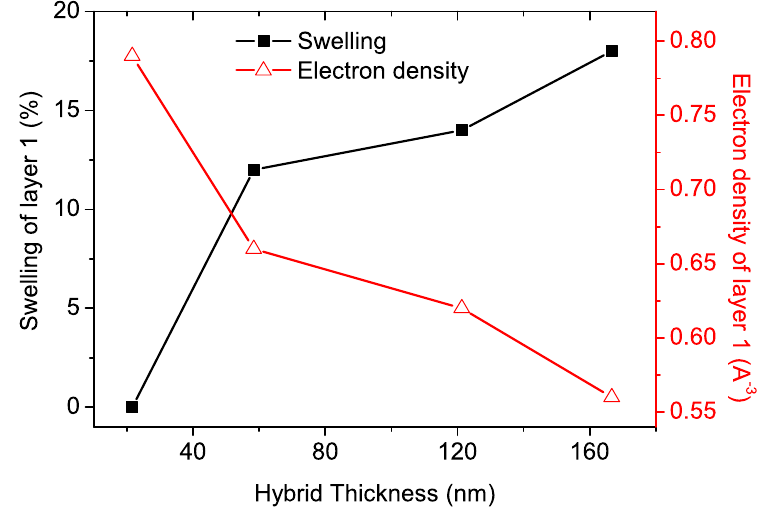
Figure 8. Swelling of Layer 1 (squares) and electron density of Layer 1 (circles) as a function of PDMAEMA/AuNP-13 hybrid